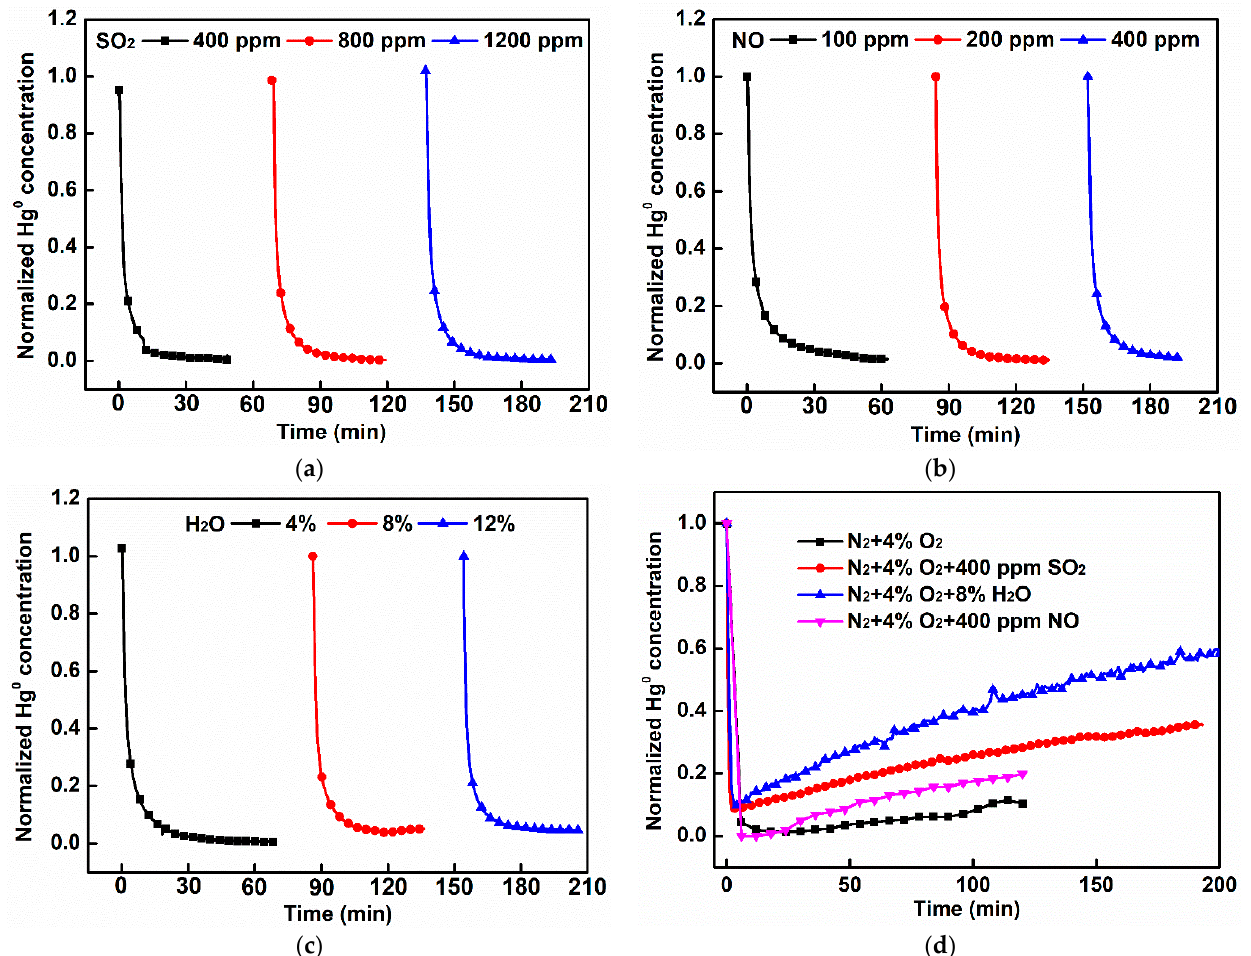
Figure 10. Effects of ( a ) SO 2 , ( b ) NO, and ( c ) H 2 O on the Hg 0 removal performances of S-Cs and ( d ) effects of flue gas components on the Hg 0 removal performances of S/Cs.